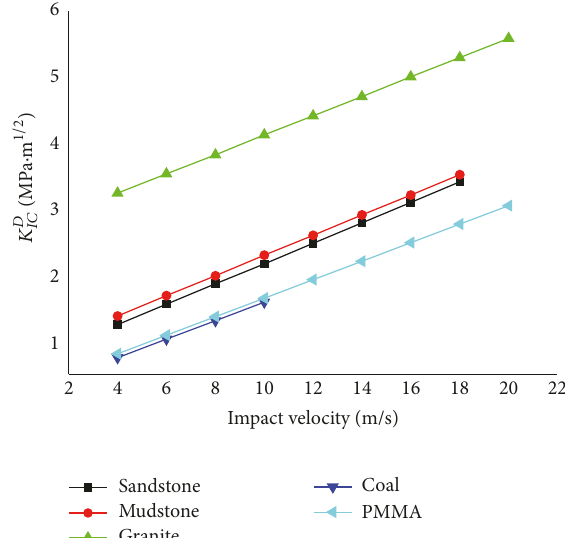
Figure 14: DLSM calculated results of the fracture toughness.